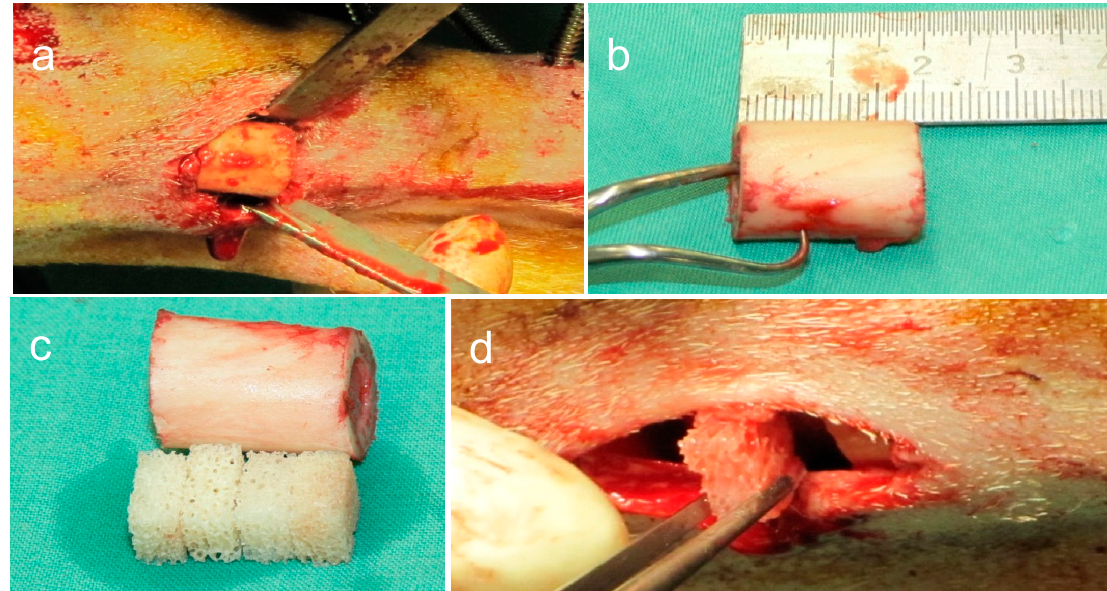
Figure 8. Bone defect. ( a ) In the middle of the tibia diaphysis the periosteum was removed and ( b ) a standardized 2.0 cm full thickness defect was created. ( c ) The bone fragment was replaced by four biomaterial scaffold blocks (test and HA group only), ( d ) which were placed in the defect area.